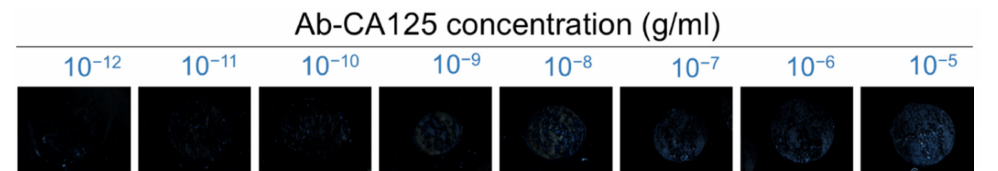
Figure 6. Optical textures of planarly aligned LCLC in the presence of the anti-CA125 antibody. The LCLC-based protein detection was performed with an aqueous solution of 14-wt% DSCG as the sensing medium in contact with 10 − 12 –10 − 5 g/mL anti-CA125 antibody immobilized on the PI-coated glass